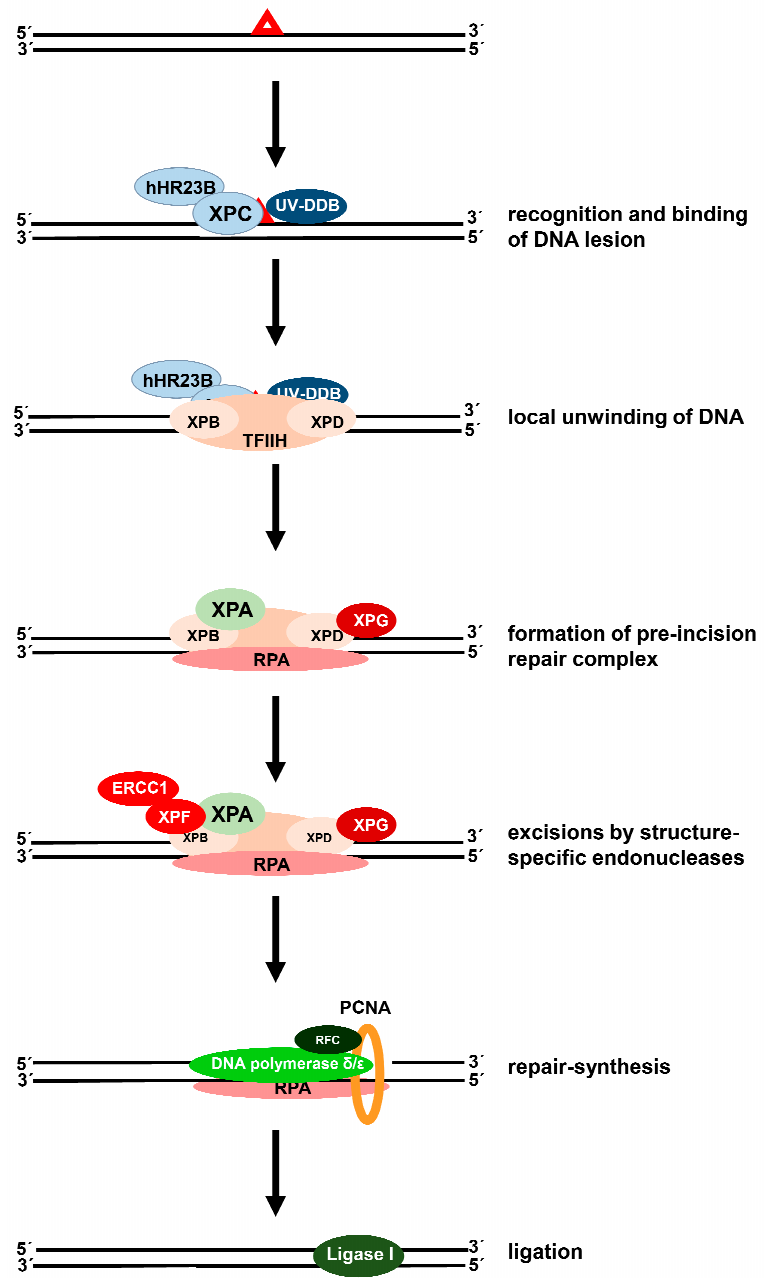
Figure 2. Mechanism of human nucleotide excision repair. The repair proteins XPC-hHR23B and UV-DDB detect and bind to the DNA lesion (red triangle). The transcription factor TFIIH with its helicase subunits XPB and XPD is recruited to the damage, leading to local unwinding of the DNA around the lesion. A pre-incision complex is formed by recruitment of XPA, RPA, and XPG, followed by incisions on both sides of the damage, mediated by the endonucleases XPG and ERCC1-XPF complex. DNA polymerase δ / ε , supported by PCNA and RFC, catalyze DNA re-synthesis, the nick is sealed by DNA ligase